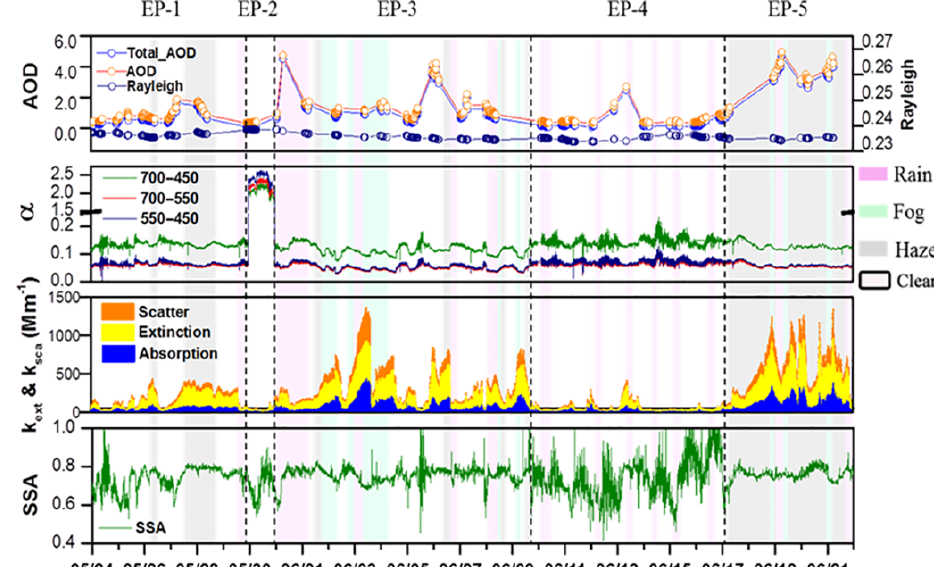
Figure 3. Variation in optical parameters during the study period. (a) Total aerosol optical depth (AOD), and AOD resulting from Mie scatter and Rayleigh scatter; (b) Ångström exponent (Å) computed from the pairs of 700 and 450nm, 700 and 550nm, and 550 and 450nm; (c) light extinction, absorption and scattering coefficients; (d) calculated single-scattering albedo (SSA).